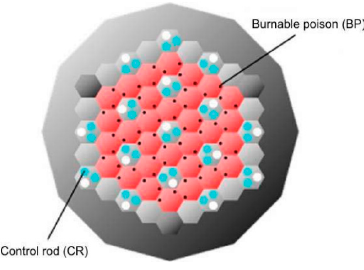
Figure 1 . Reactivity control in the HTTR. Figure 1. Reactivity control in the